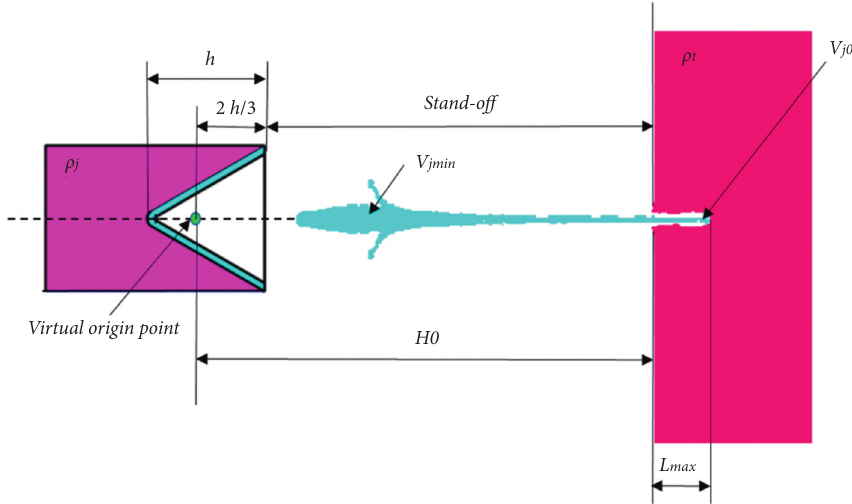
Figure 10: Theoretical calculation model of continuous jet penetrating target.